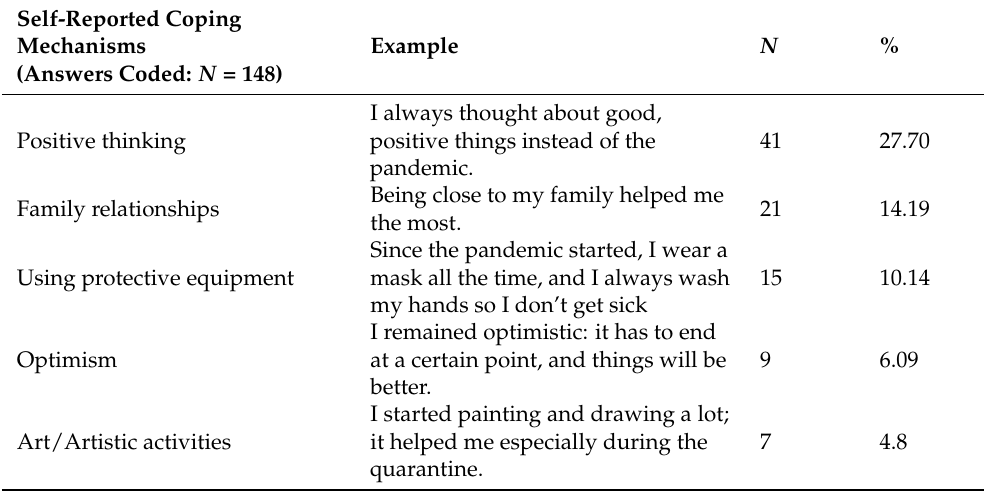
Table 6. Perception of self-reported and others’ perceived coping mechanisms during the COVID-19